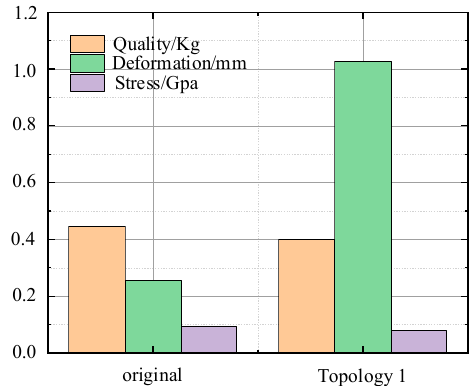
Figure 17. The effect of topology